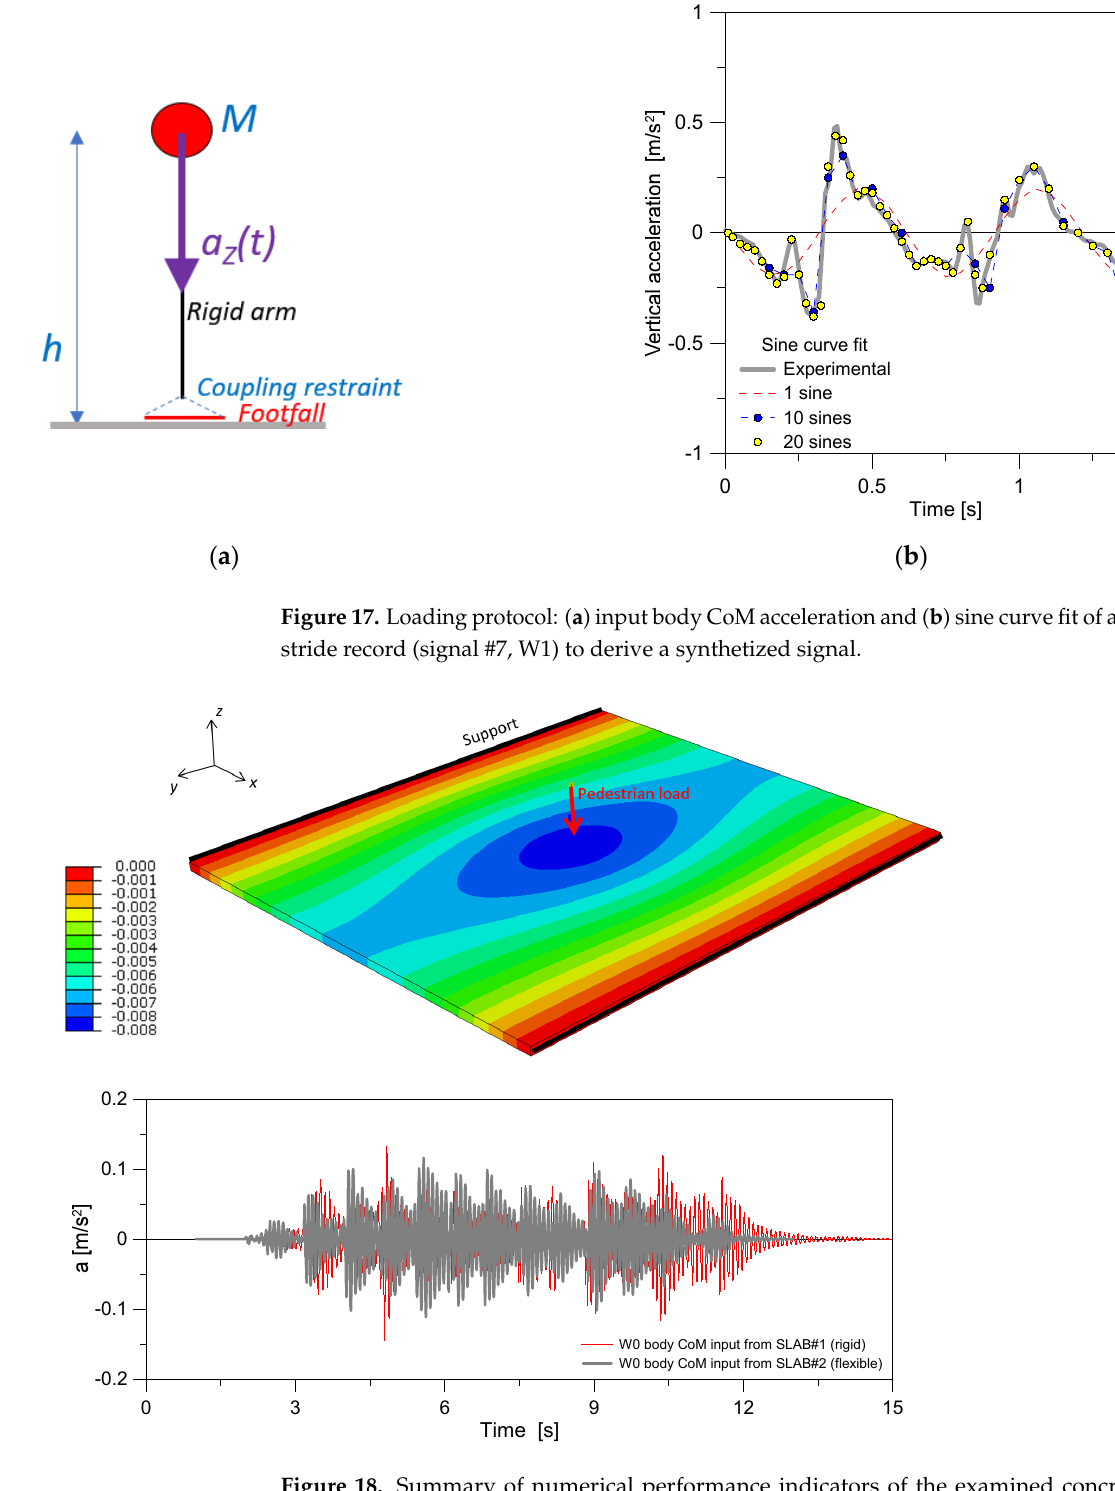
Figure 18. Summary of numerical performance indicators of the examined concrete slab under W0 experimental body CoM accelerations or deterministic pedestrian loads (ABAQUS): ( a ) typical acceleration distribution (values in m/s 2 ), with ( b ) acceleration at the center of slab.